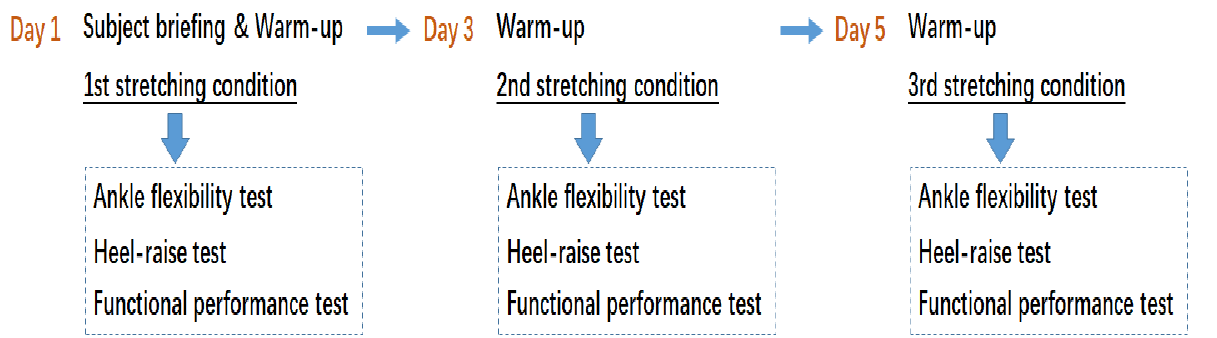
Figure 3. Experimental procedure over three test days. The regular stretching, soleus stretching and control conditions were randomly assigned across participants.